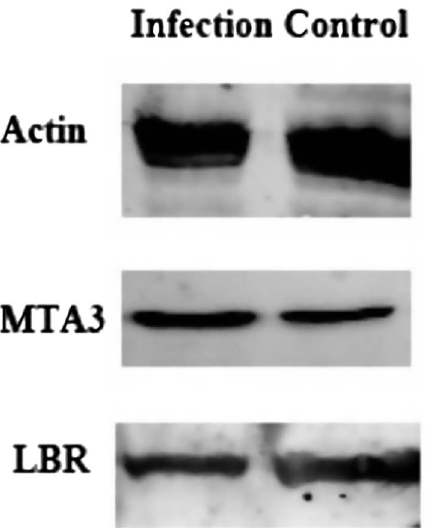
Figure 5. Western blot analysis of MAT3 and LBR in BHK cells infected with Eimeria tenella compared with mock-infected